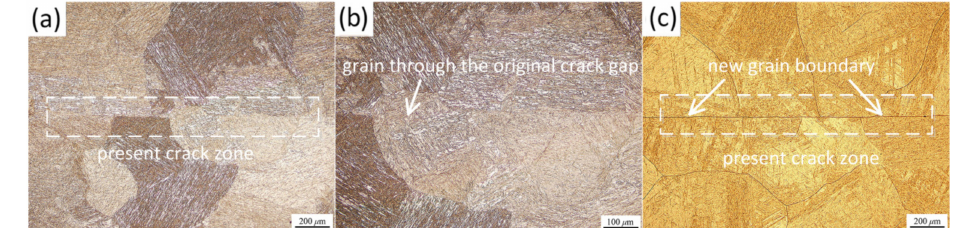
Figure 7. Optical micrographs of the crack healing zone at 1200 ◦ C for 60 min: ( a ) microstructural morphology etched in 4% nital showing the present crack zone; ( b ) magnified image of Figure 7a showing mutual grain; and ( c ) grain boundaries etched in a picric acid-saturated water solution showing the new linear mutual grain